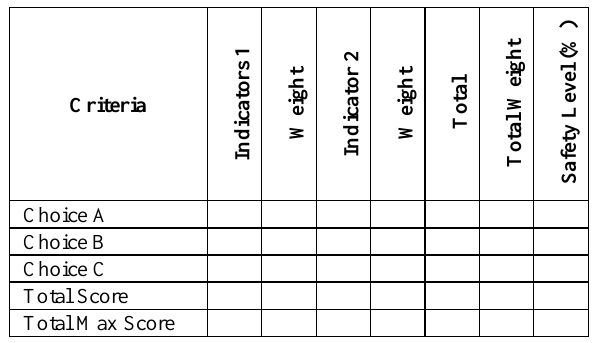
Table 6. Matrix to calculate the total weight and safety level in this study.